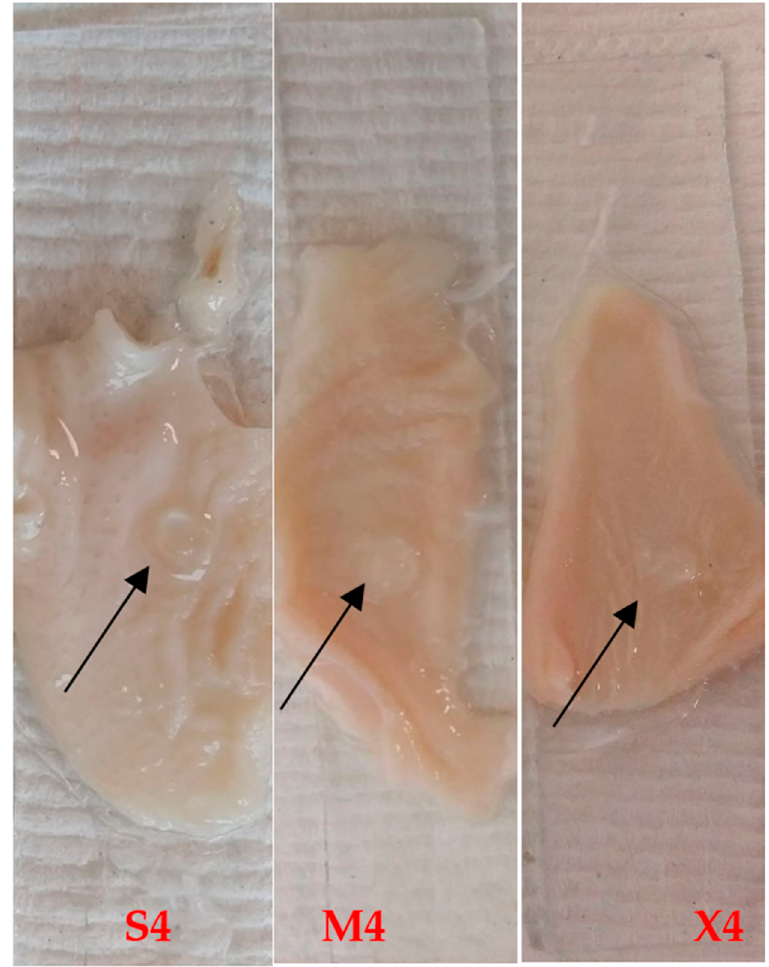
Figure 3. S4, M4, and X4 after two-hour ex vivo mucoadhesion using disintegration apparatus. The arrows show the hydrogel tablet after two hours.